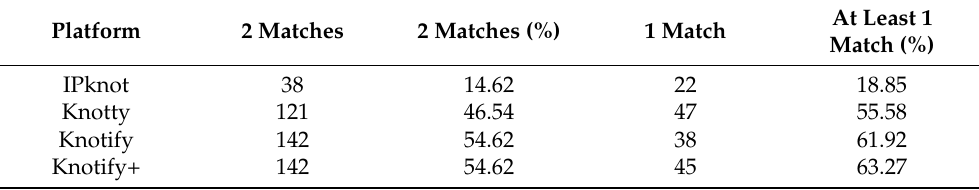
Table 2. Pseudoknot location prediction according to the core stems in the whole dataset.